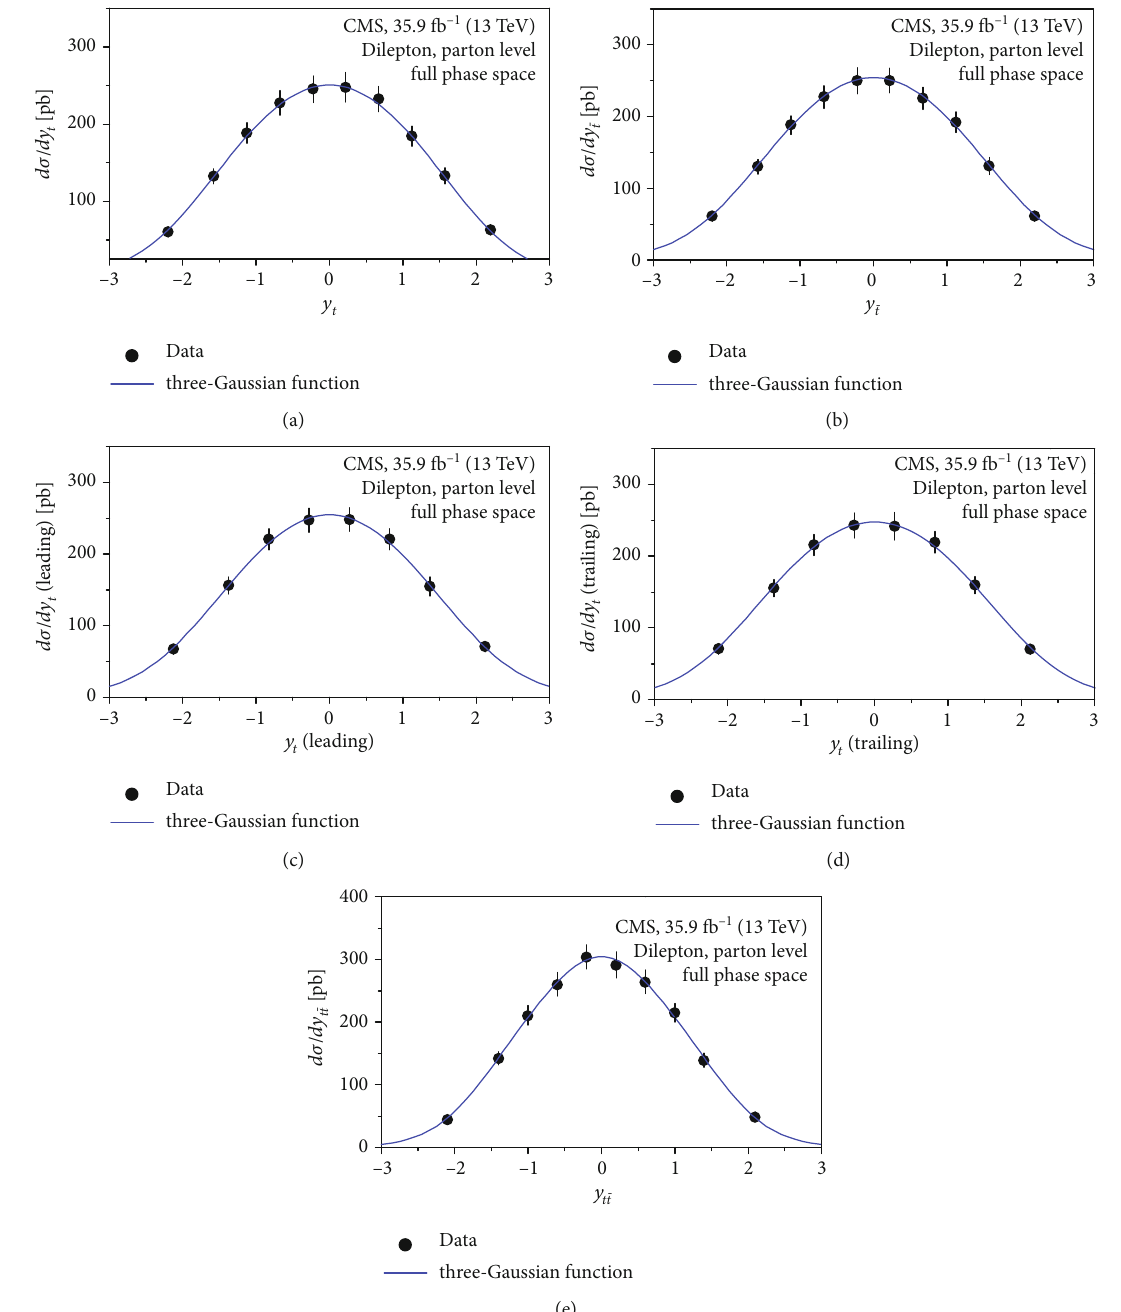
y (cid:1) t ), (c) the top quark or top antiquark with the largest t ), (b) the top antiquark ( ffiffi p s = 13 TeV. The solid circles represent the experimental data of the CMS Collaboration in literature